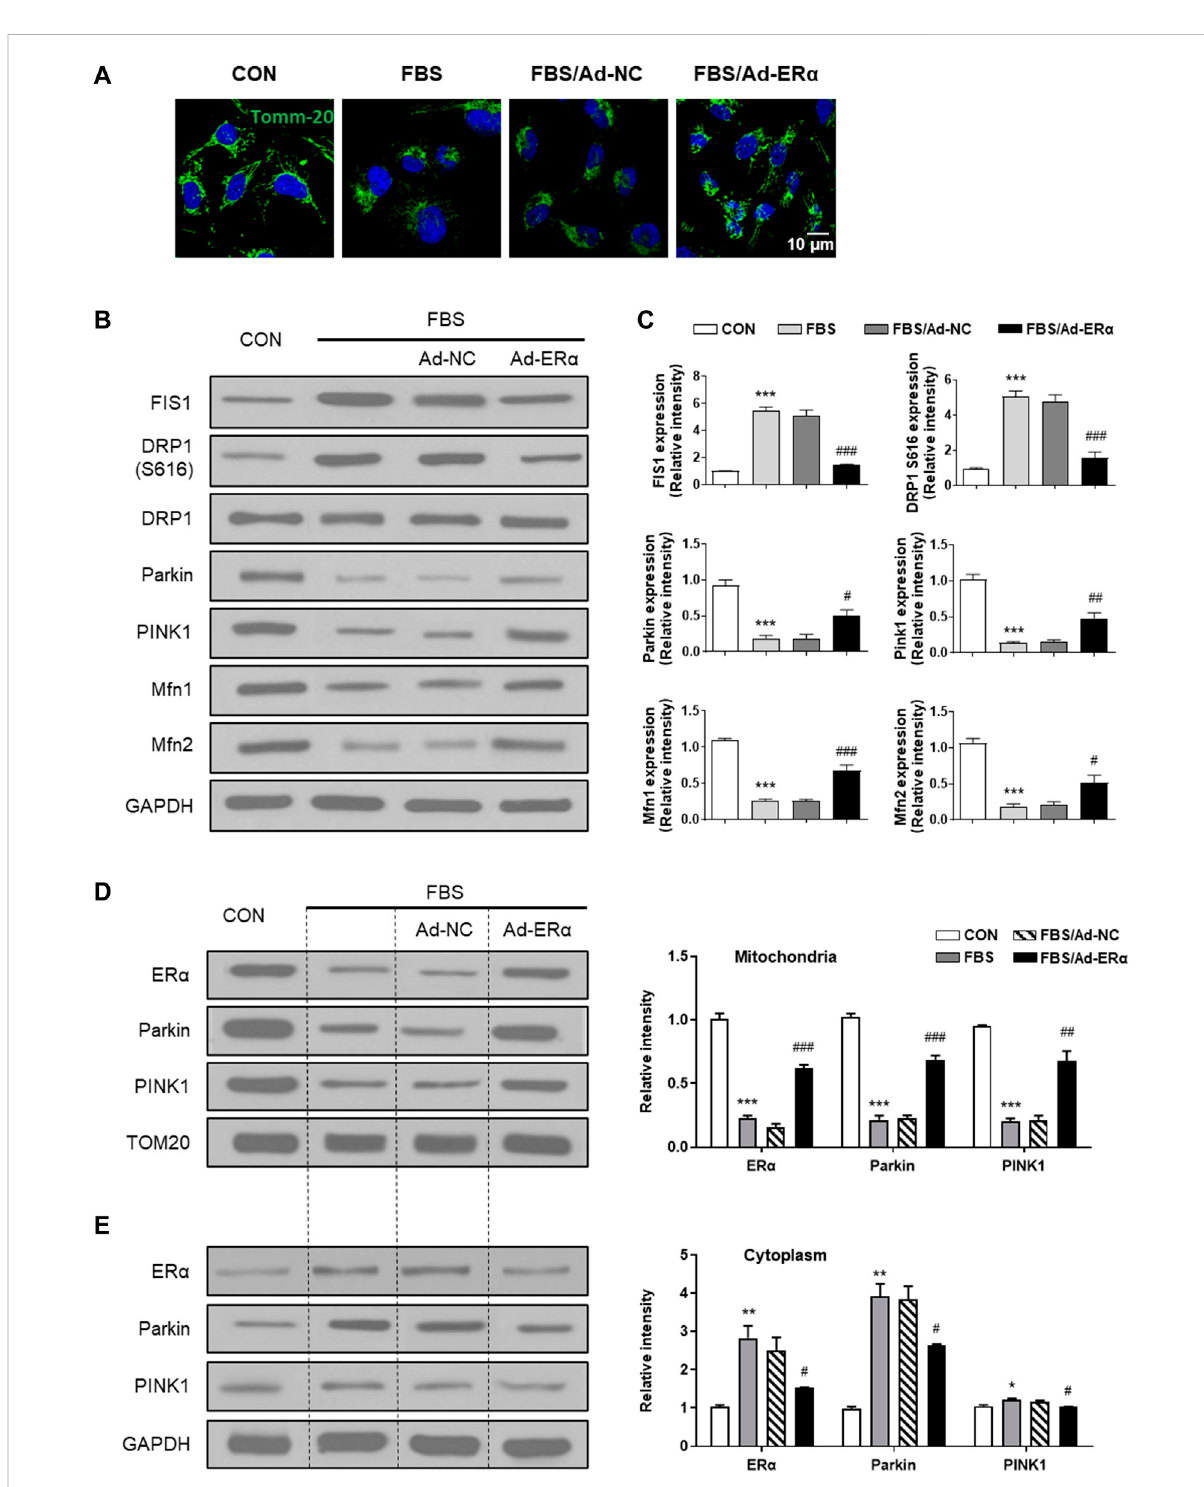
FIGURE 3 ER α regulates mitochondrial dynamics and mitophagy signaling. (A) Representative images of immuno fl uorescence staining for TOMM20 (green) and DAPI (blue) in A7r5 cells. (B,C) Western blot analysis (B) and quanti fi cation compared to GAPDH (C) of FIS1, DRP1 S616, DRP1, Parkin, PINK1, Mfn1 and Mfn2 protein levels in A7r5 cells. (D,E) Left, western blot analysis of ER α , Parkin and PINK1 protein levels in mitochondria (D) and cytoplasm (E) of A7r5 cells, respectively. The A7r5 cells mentioned above were incubated with FBS for 72 h after transfected with adenoviruses expressing ER α or noncoding control for 48 h. * p < 0.05, ** p < 0.01 and *** p < 0.001 vs. control; # p < 0.05, ## p < 0.01 and ### p < 0.001 vs.